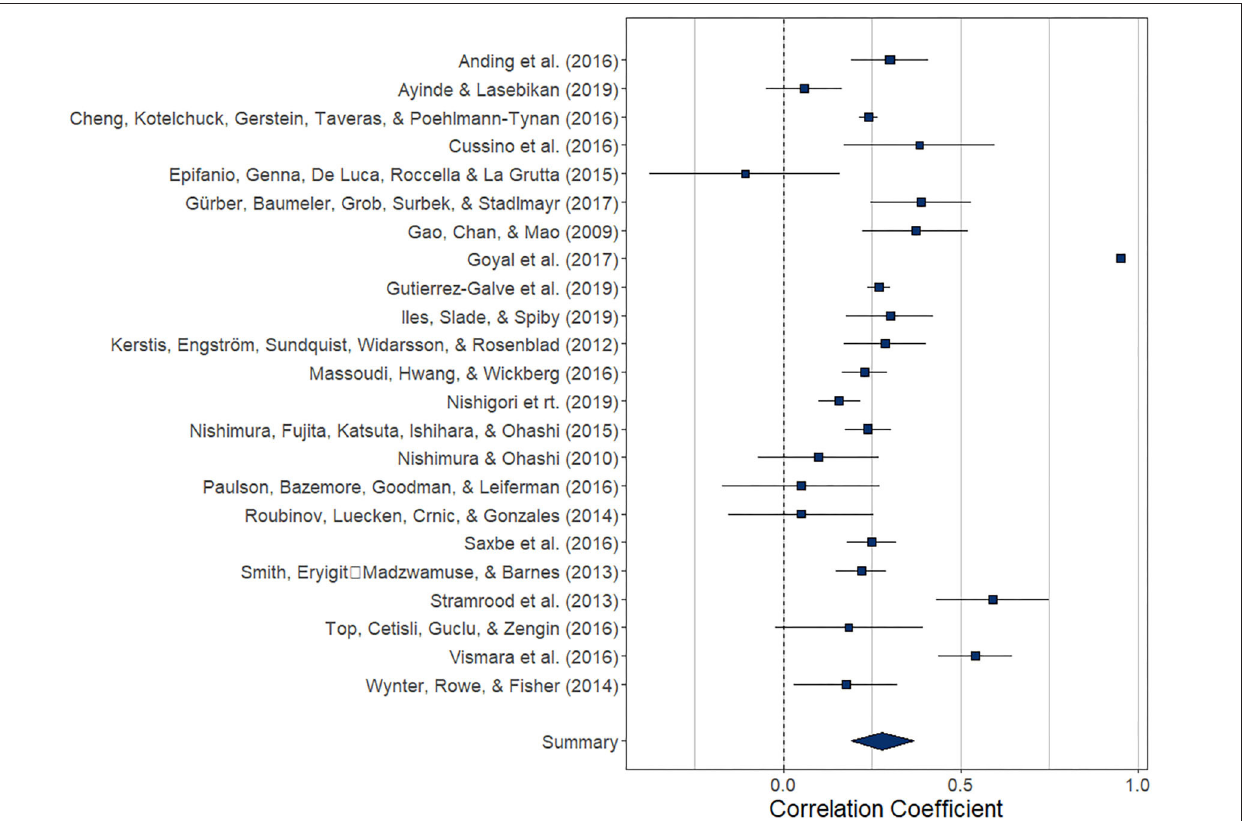
FIGURE 4 | Forest plot of the analysis of the association between paternal and maternal depression during the postnatal period. Weighted effect size and 95% CI are presented on the